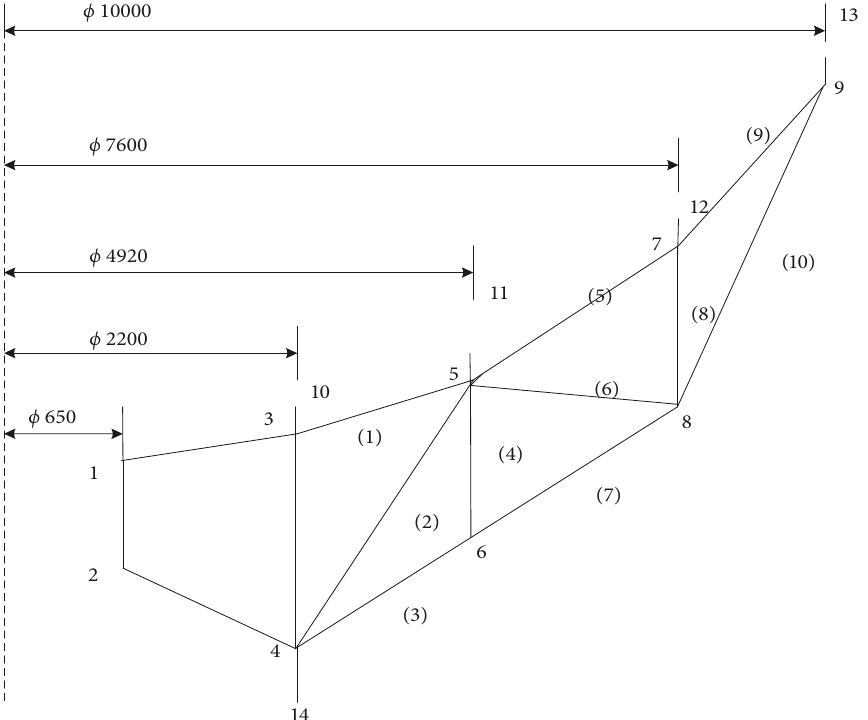
Figure 3: Layout of the main beam’s web